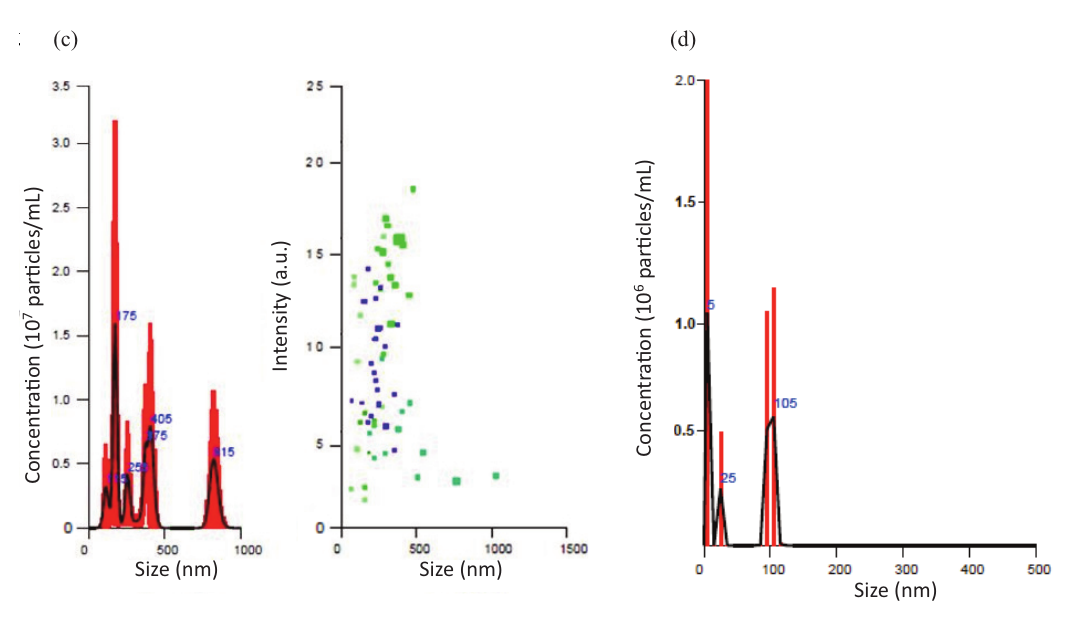
Particle size (nm) and distribution at [SrS] = 1.671 ± 0.01 mM (pH = 11.18 ± 0.02); the average concentration of particles is 1.74 ± 0.61·10 7 per mL. Fig. 2. Size distribution and the average concentration of particles from the NTA measurements in the closed equilibrium systems of H 2 O–SrS (at [SrS] = 0.092–1.671(± 0.01); pH = 9.97–11.18(± 0.02)) and H 2 O–CaS (at [CaS] = 0.097–1.733(± 0.01); pH = 9.94– 11.26(±0.02)) at 25 ± 0.2 °C. Red error bars indicate the standard error of the average concentration of particles in the measured systems. ( Continued on the next